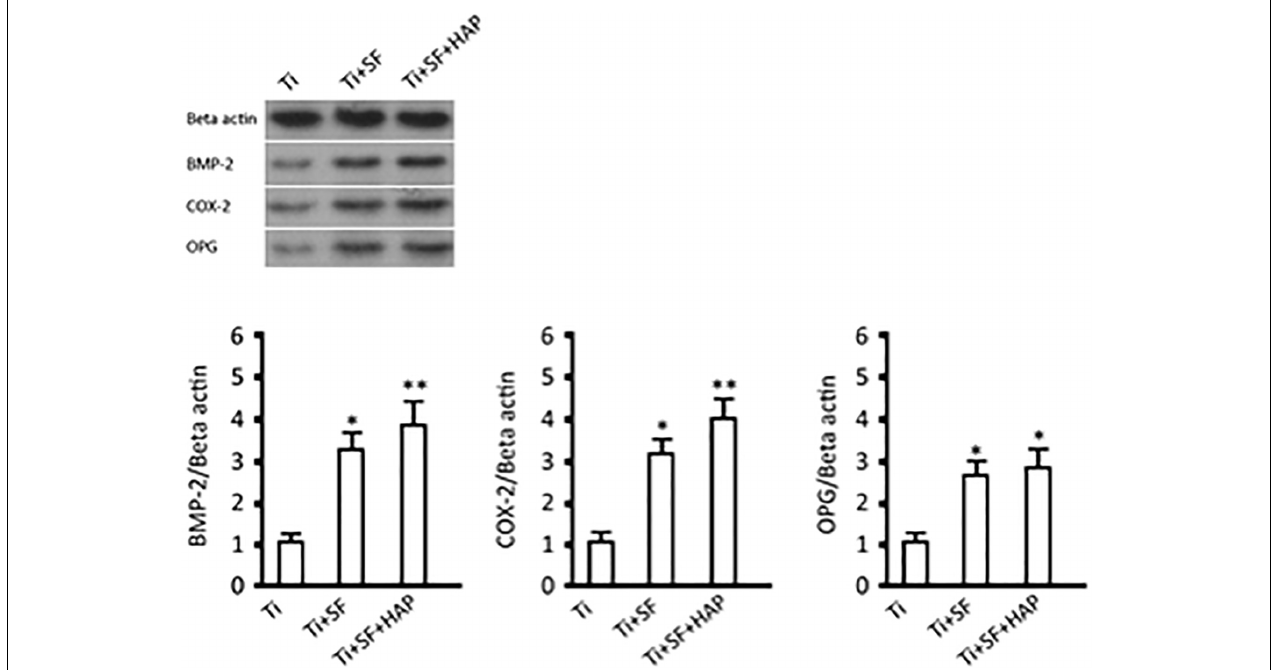
FIGURE 7 | BMP-2, COX-2, and OPG expressions and protein contents ( ∗ indicates p < 0.05 and ∗∗ indicates p <